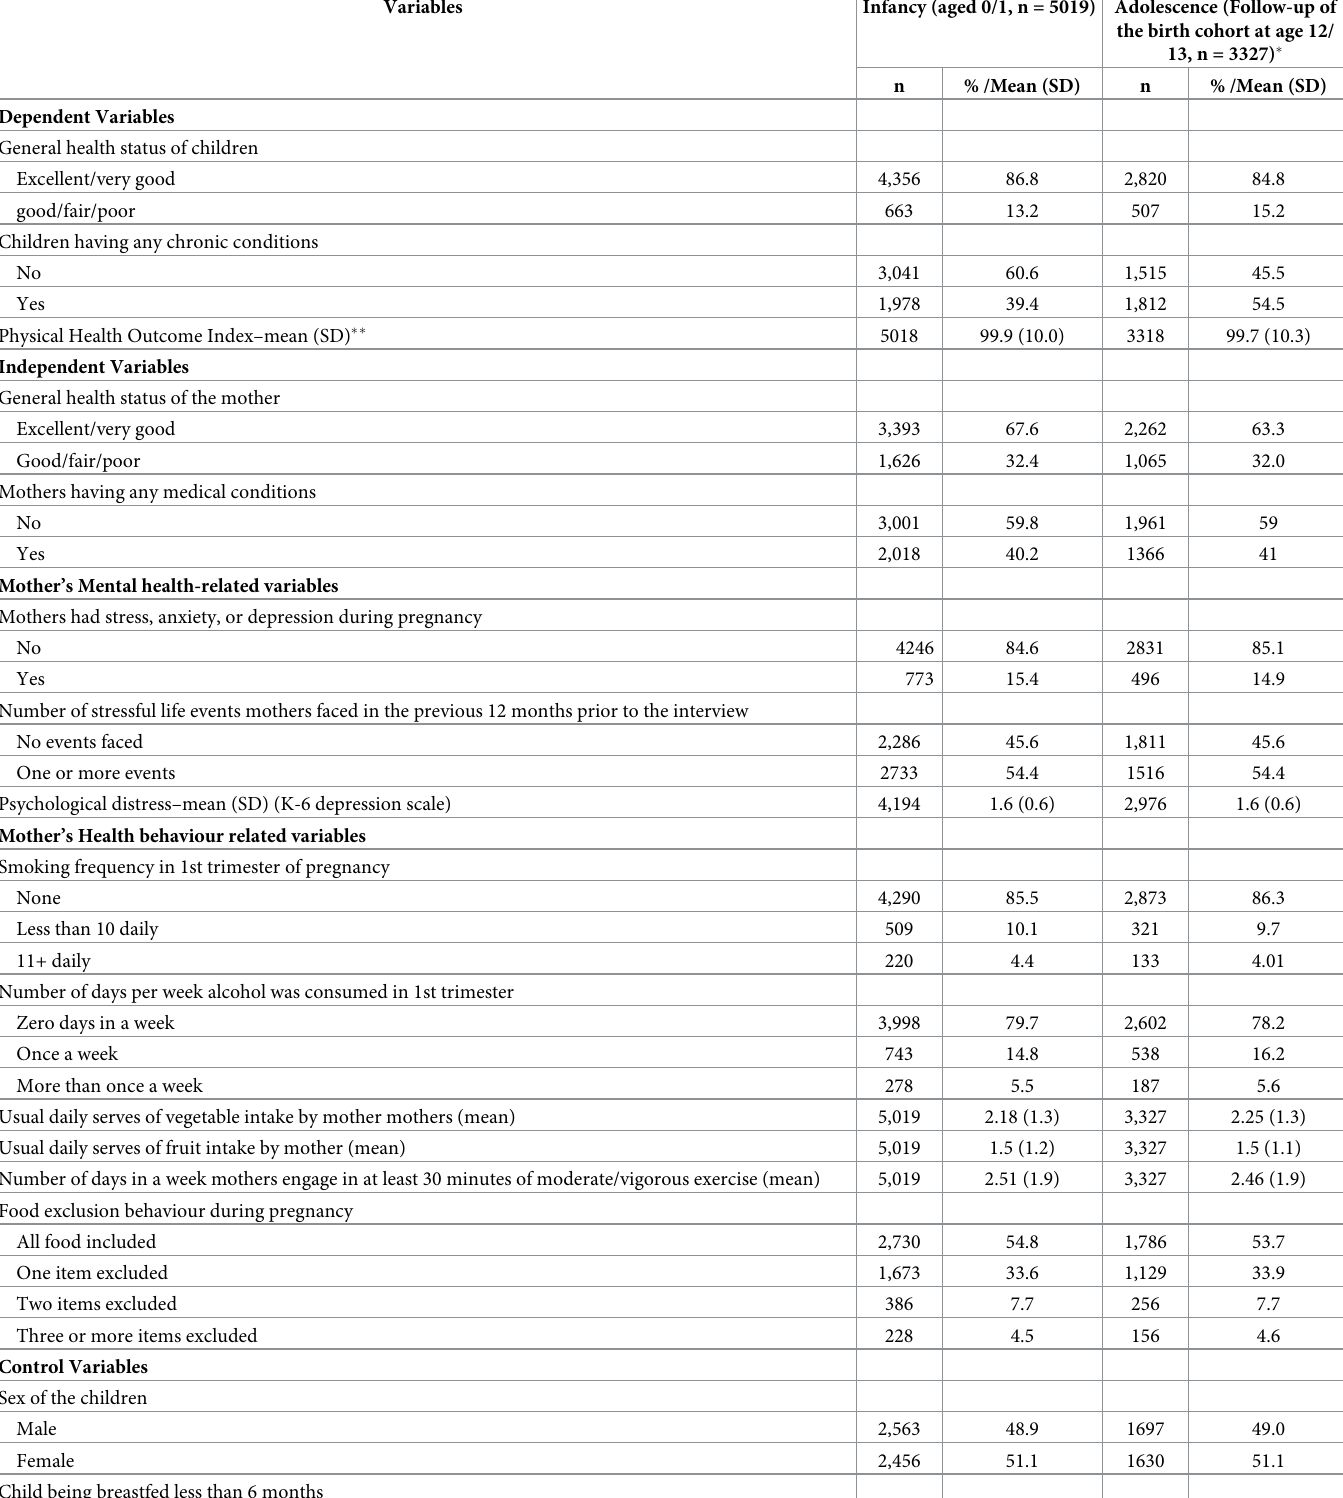
Table 1. Characteristics of the sampled subjects during infancy and adolescence time of the study children � .